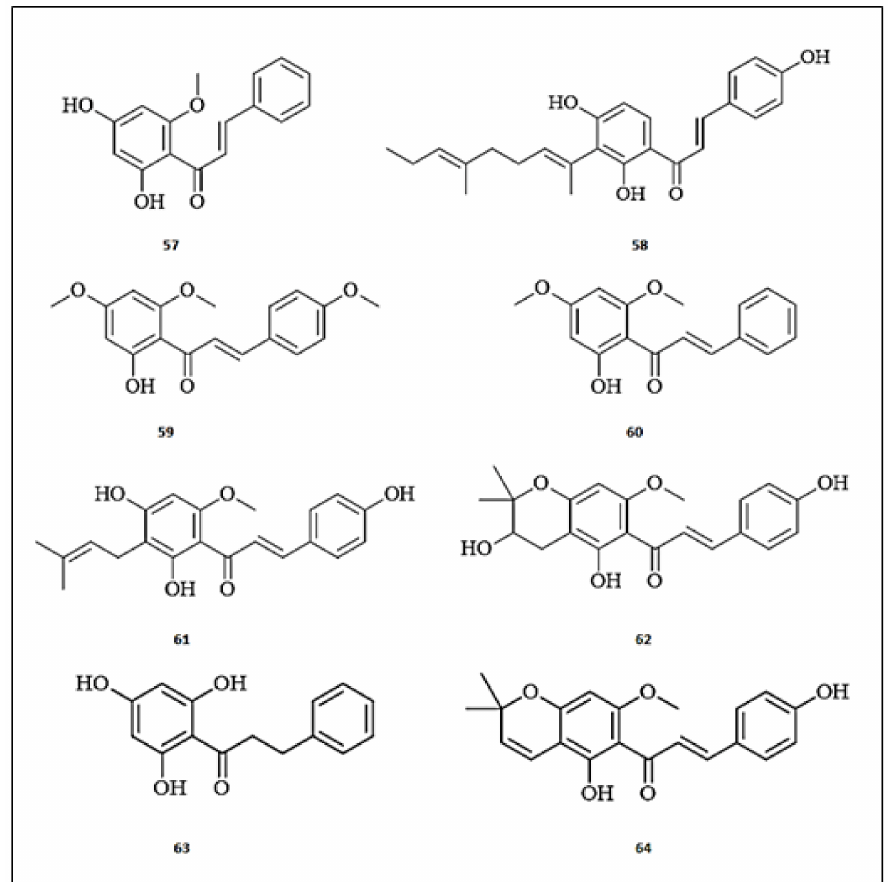
Figure 7. The chemical structures of chalcones with anti-tyrosinase activity. ( 57 ) 2 (cid:48) 4 (cid:48) -dihydroxy-6 (cid:48) - methoxy-chalcone; ( 58 ) Xanthoangelol; ( 59 ) Flavokawain A; ( 60 ) Flavokawain B; ( 61 ) Xanthohumol; ( 62 ) Xanthoumol B; ( 63 ) Xanthohumol C; ( 64 ) 2 (cid:48) ,4 (cid:48) ,6 (cid:48)